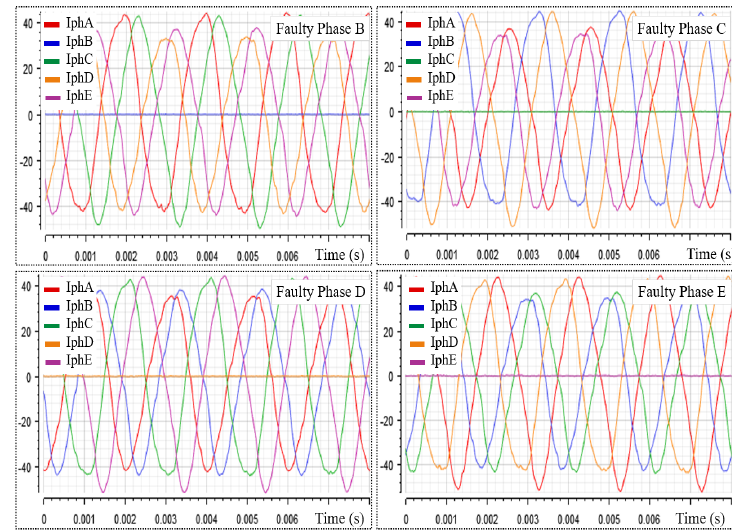
Figure 14. Electromagnetic torque waveforms.